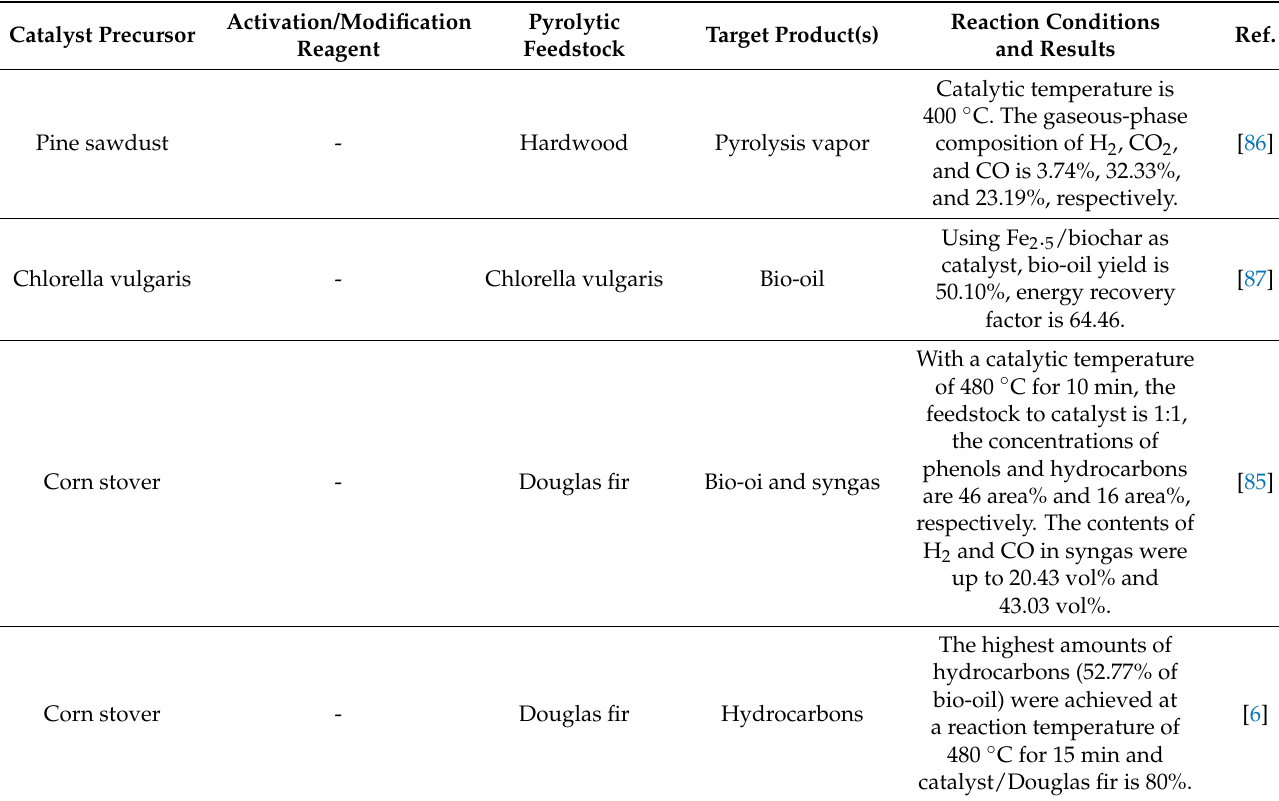
Table 3. Reaction conditions and results of catalytic pyrolysis of different LB with